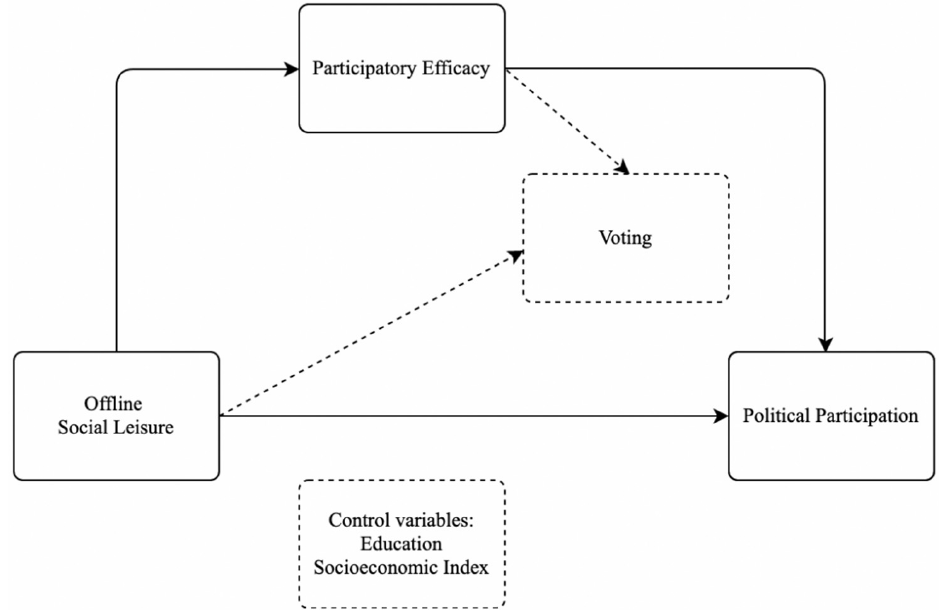
Figure A1. Pathway model of the relationship between offline social leisure and political participation. The political participation variable does not contain voting. The full lines denote the main analysis pathways, whereas dotted lines represent the aims for exploratory analysis.